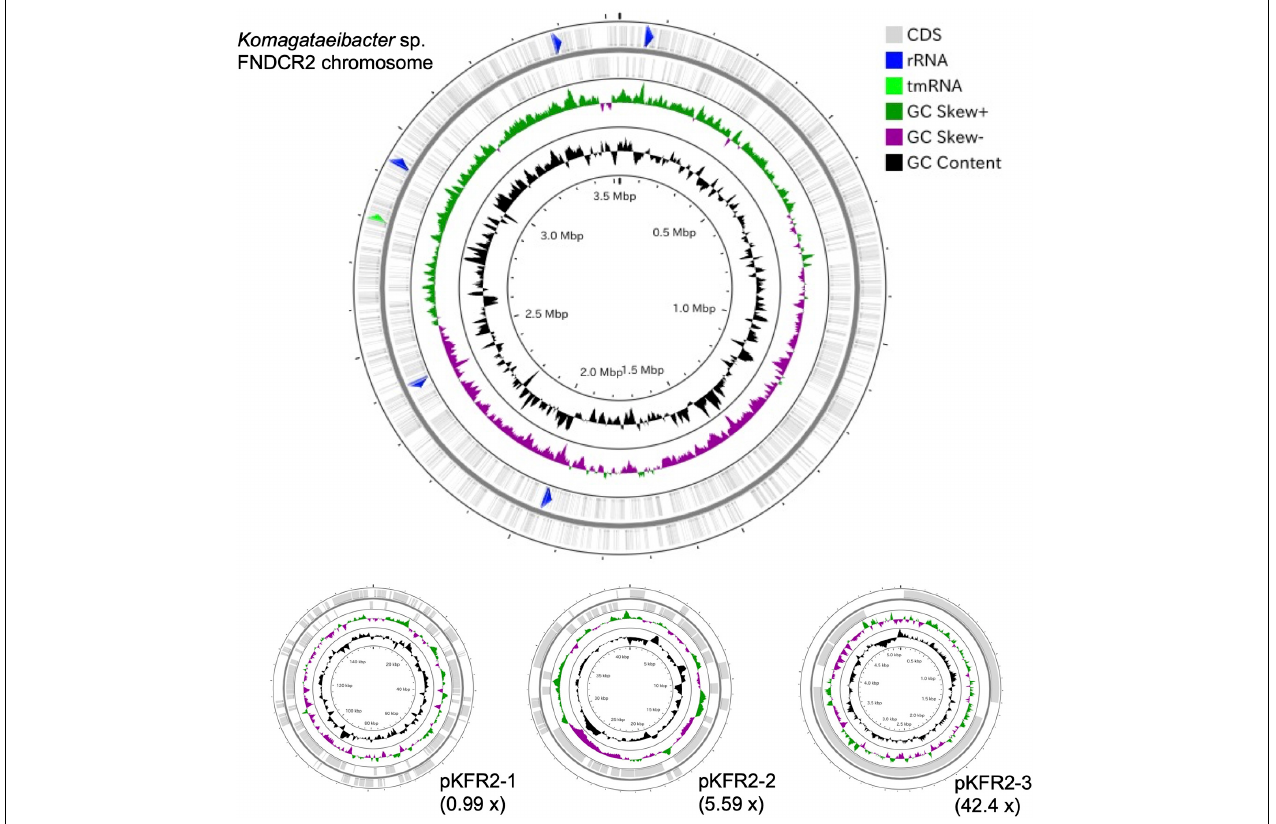
FIGURE 4 | Genome structure of the FNDCR2 strain. One circular chromosome and three putative plasmids (pKFR2-1, pKFR2-2, pKFR2-3) are shown. The value given in parentheses represents the sequencing coverage of a plasmid relative to that of chromosome. Smaller contigs below 5,000 bp and non-circularized contigs are not shown in this